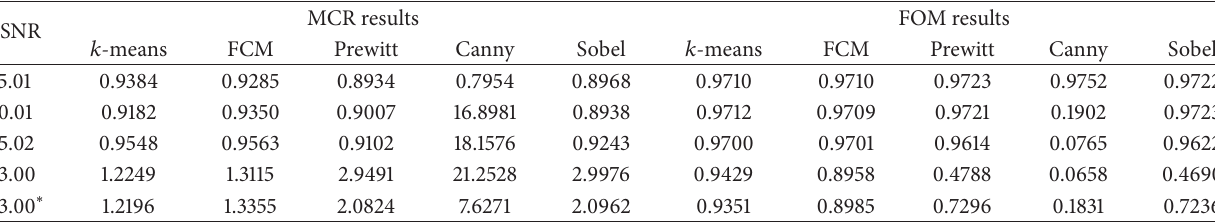
Table 2: MCR and FOM results for the phantom image in Figure